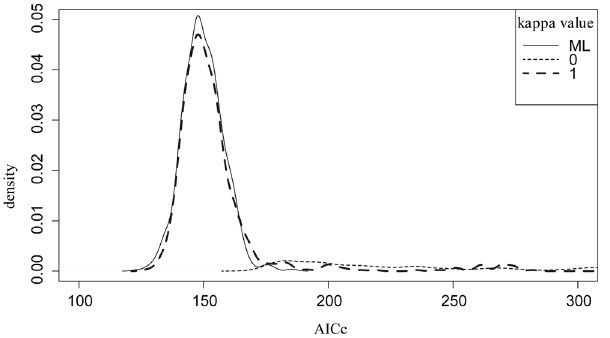
Figure 5. Density distribution of Pagel’s kappa model support over 1000 Bayesian post burn-in phylograms for Agrodiaetus species. AICc is Akaike information criterion riteria with a correction for finite sample sizes, the smaller the AICc means the more plausible the